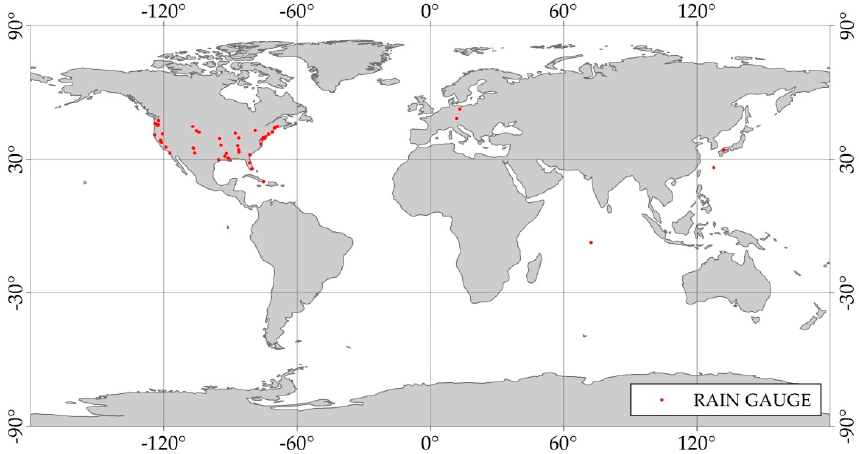
Figure 1. The spatial distribution of the rain gauges used for the evaluation of the accuracy of GPM (Global Precipitation Measurement) IMERG (Integrated Multi-satellite Retrievals for GPM) data. The reference system is WGS84.